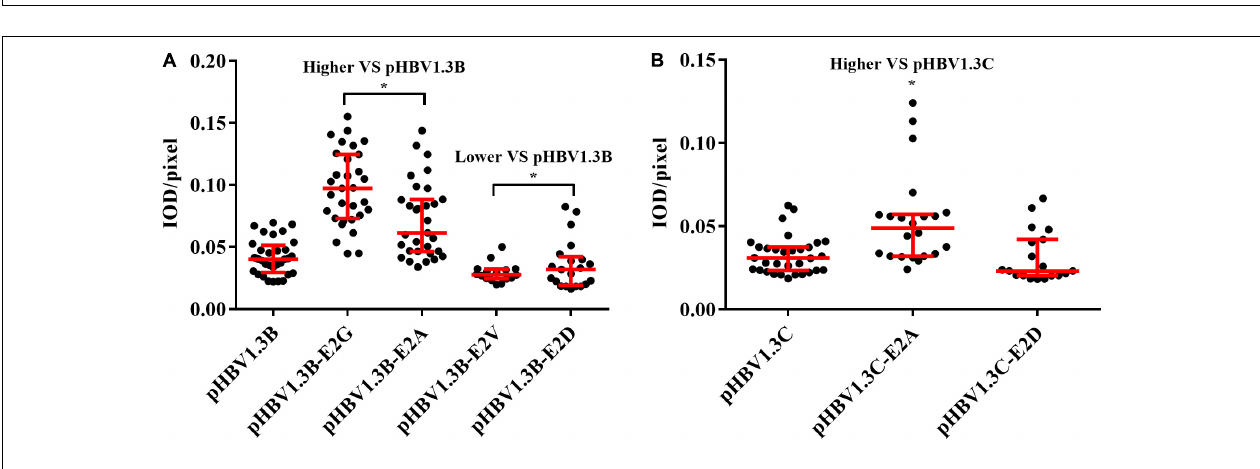
Frontiers in Microbiology |